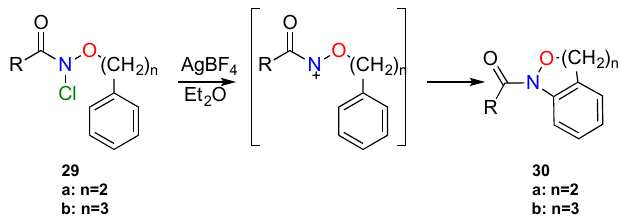
Scheme 3. Cyclisation by silver ion catalysed elimination reactions.